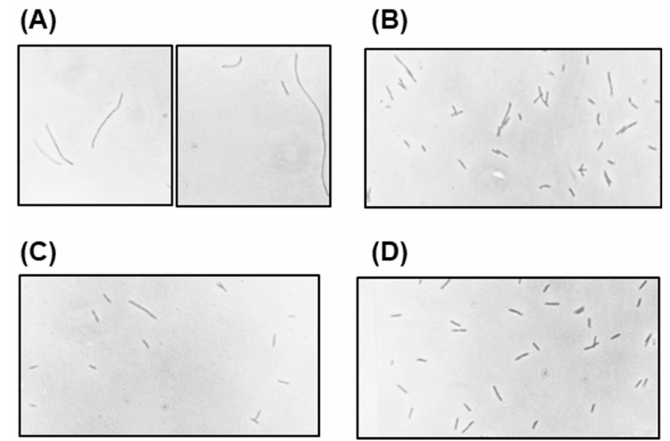
Figure 11. Photomicrographs of di ff erent polylysogens, compared to the nonlysogen. Bacteria from freshly grown cultures of the following were photographed at 475 × : ( A ) indistinguishable cells of 594( λ N - c I - ) or 594( λ N - c I - R - ) or 594( λ N - c I - S - ) or 594( λ N - c I - R - S - ), presented in a single panel representing all, to save space; ( B ) 594( λ N - c I - O - ); ( C ) 594( λ N - c I - P - ); ( D )